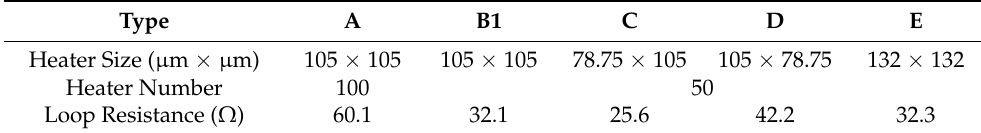
Table 1. List of resistance measurement of single circuit resistance.